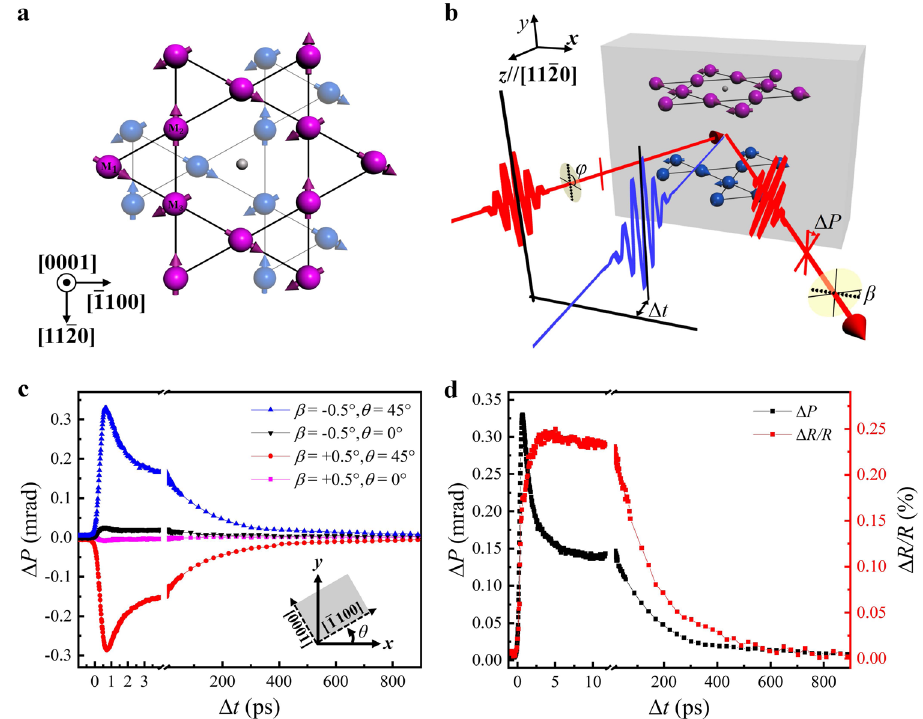
Fig. 1 Experimental observation of the ultrafast modulated Voigt effect in Mn3Sn fi lm. a Non-collinear inverse triangular spin structure of Mn 3 Sn. Purple and blue spheres with arrows represent Mn spins; small dark gray spheres represent Sn atoms. b Schematic experimental setup. The 400-nm pump laser pulse (blue) induces a quench of AFM order, and the 800-nm probe laser pulse (red) detects Δ P via crossed polarizers. The sample can be rotated around the z axis parallel to ½ 11 (cid:1) 20 (cid:3) . The sample orientation in the schematic is θ = 0°. β and φ describe the polarizer angle and probe light polarization angle, respectively. Δ t represents the time delay. c Time evolution of the Δ P at room temperature for sample orientation of θ = 45 ° and θ = 0°. θ = 0° corresponds to the crystallographic direction ½ (cid:1) 1100 (cid:3) parallel to the x axis. d Comparisons of the Δ R and Δ P at T = 300